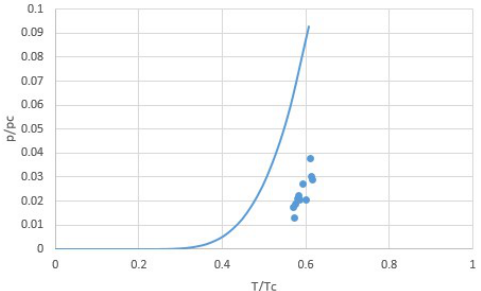
Figure 5. Van der Waals normalized vapor pressure lines p 0 / p c as a function of normalized boiling temperatures T 0 / T c at p 0 = 1 atm, together with points representing experimental values for common fluids [17]. Although the points are well off the line, both the line and the points show a similar rapid increment of p 0 / p c with T 0 / T c . Since the difference in critical pressures between common gases is limited between about 25 and 90 atm for the selected gases, and because p / p c increases so rapidly with T / T c , it follows that the ratio of boiling temperature and critical temperature T 0 / T c is roughly constant at a given pressure of e.g., p 0 = 1 atm.